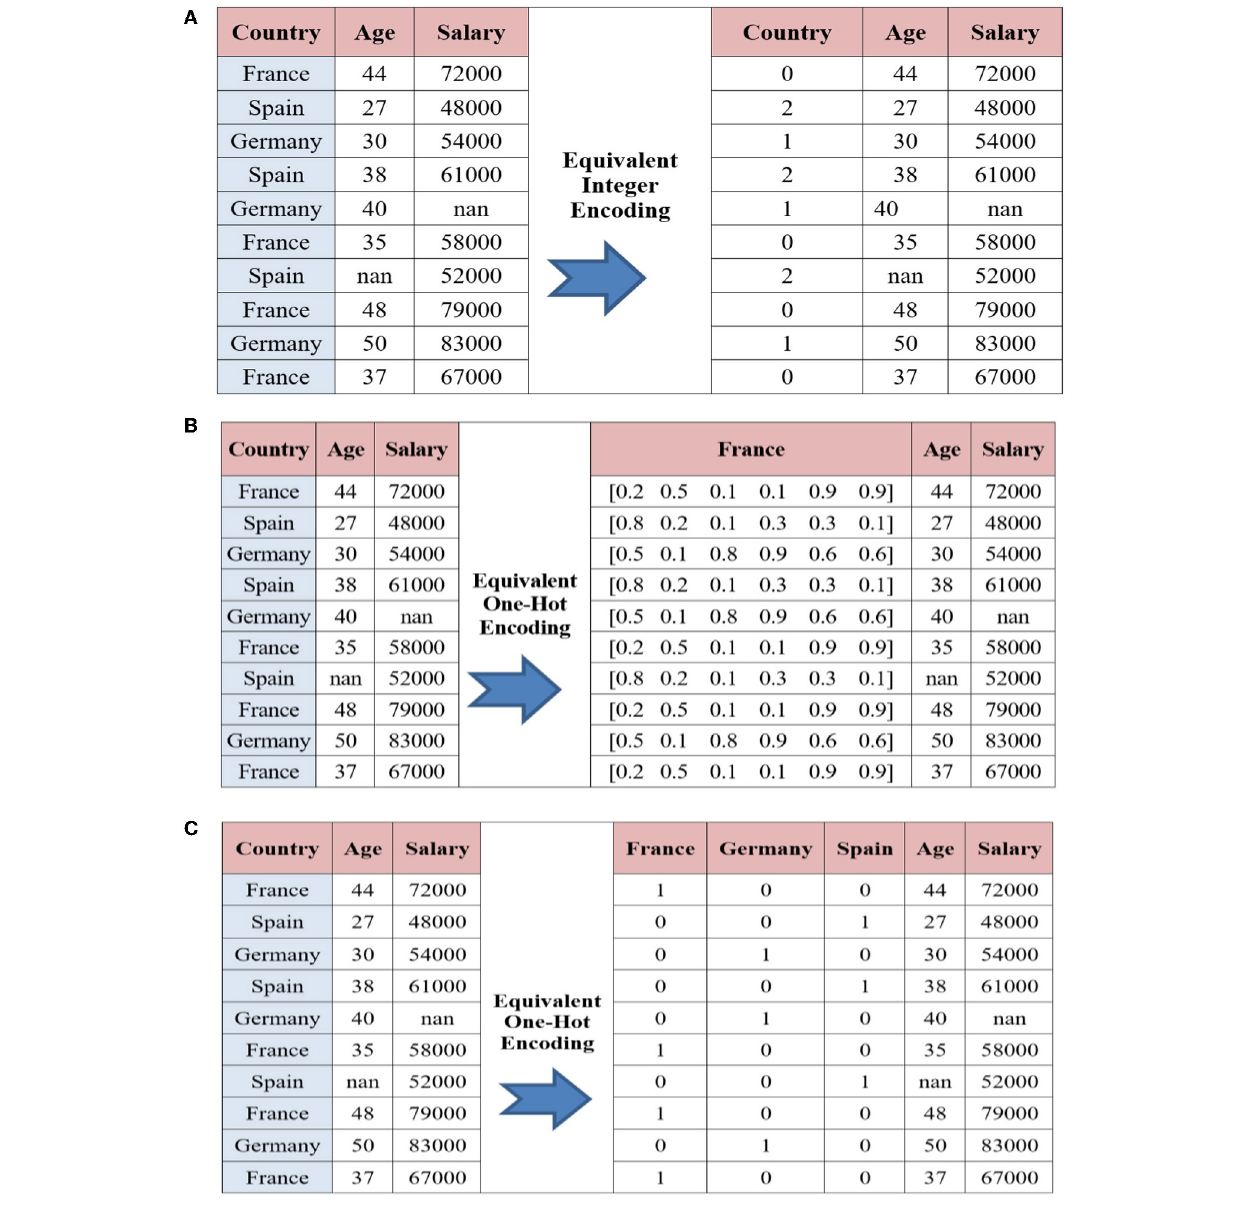
FIGURE 3 | (A) An integer encoding example of three categories (B) A learned embedding encoding example (C) One hot encoding example on City